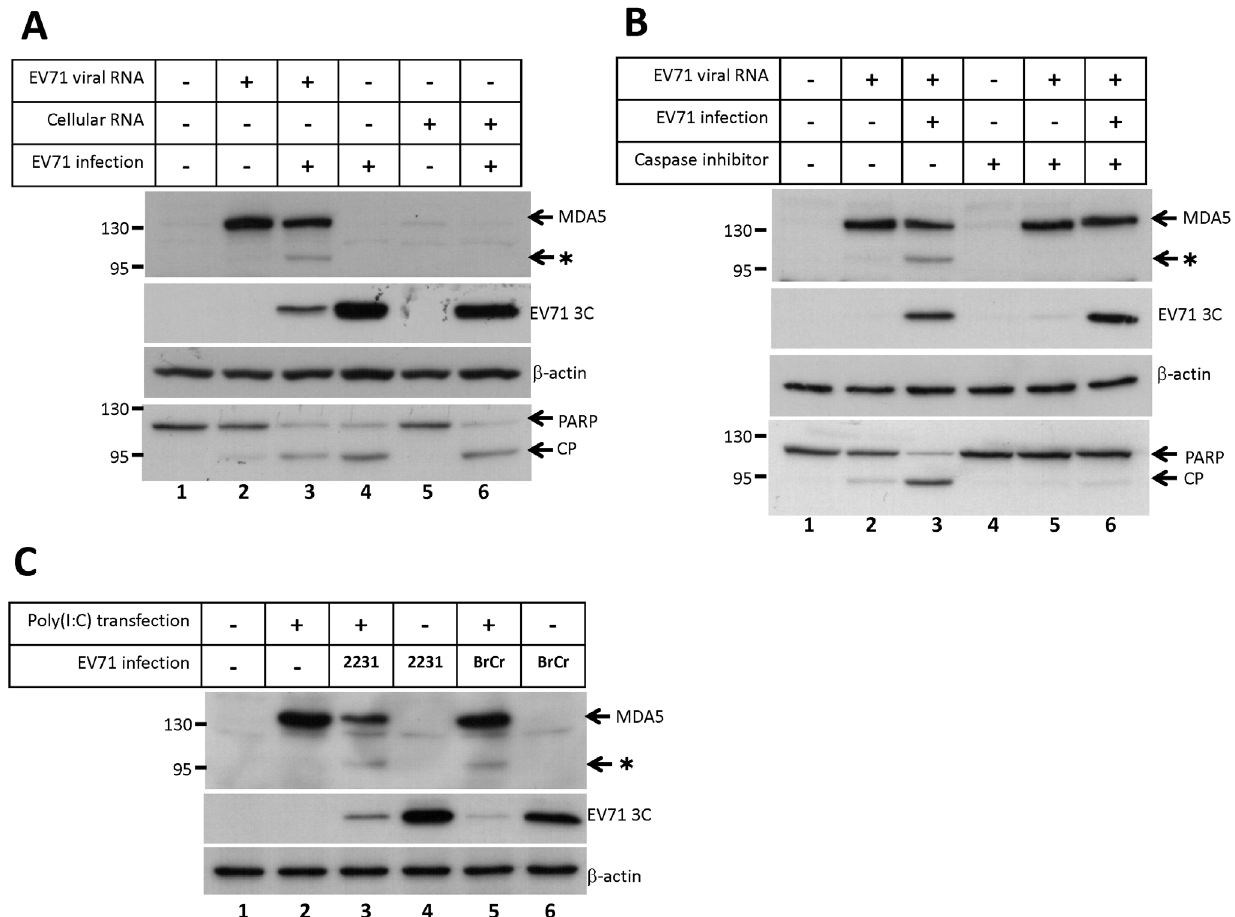
Figure 6. EV71 induces the cleavage of endogenous MDA5 protein. (A) HeLa cells were transfected with 1 m g of EV71 RNA, 1 m g of total RNA from mock-infected cells, or transfection reagent alone. At 14 h post-transfection, the cells were infected with the MP4 strain of the EV71 virus at 2 MOI. At 9 h post-infection, cell extracts were analyzed by immunoblotting using anti-MDA5, anti-EV71 3C, anti- b -actin, and anti-PARP antibodies. (B) HeLa cells were transfected with 1 m g of EV71 RNA for 14 h, followed by EV71 infection. During the virus infection, the cells were treated with a broad spectrum caspase inhibitor, Q-VD-OPH, at final concentration of 20 nM. At 9 h post-infection, cell extracts were collected and analyzed by immunoblotting using anti-MDA5, anti-EV71 3C, anti- b -actin, and anti-PARP antibodies. (C) HeLa cells were transfected with 2 m g of poly(I:C) or transfection reagent alone for 16 h, and subsequently infected with the TW2231/98 or the BrCr strain of the EV71 virus at 2 MOI. At 9 h post-infection, cell extracts were analyzed by immunoblotting using anti-MDA5, anti-EV71 3C, and anti- b -actin antibodies. The asterisk indicates the putative cleavage product of the MDA5 protein, and CP indicates the cleavage product of the PARP protein.